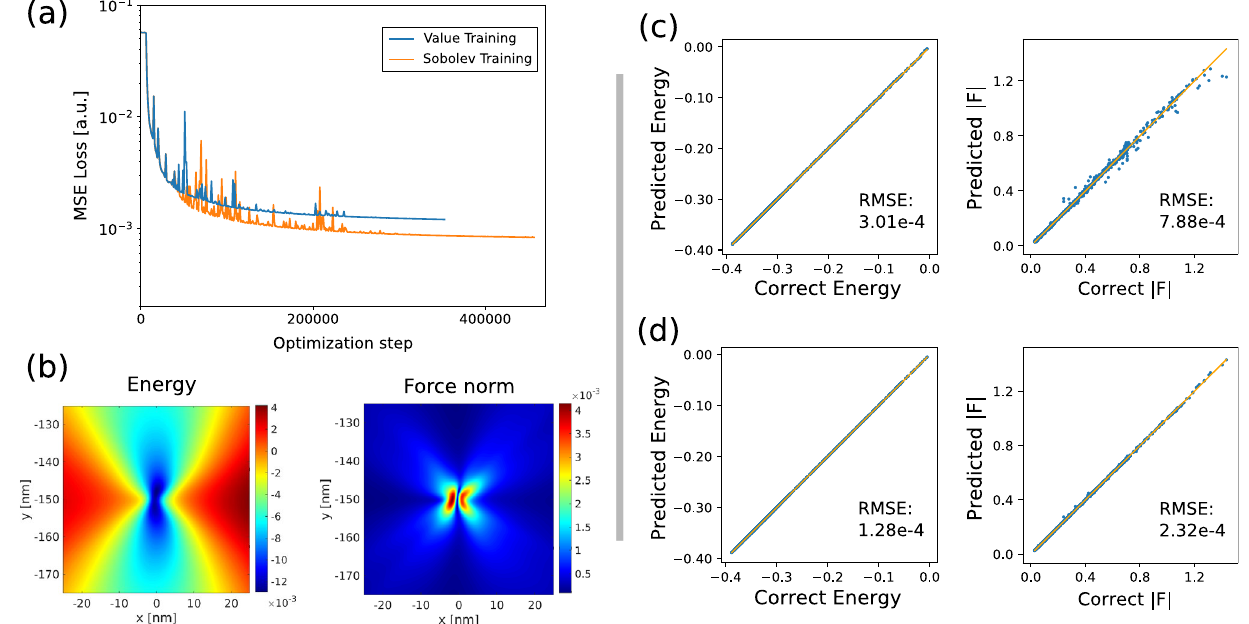
Figure 2. ( a ) Loss function calculated on the validation set during NN parameters optimization using Value (blue line) and Sobolev training (orange line). ( b ) Plot of energy and force near a dislocation as predicted from the NN model. Regression plots for the H term (both energies and forces) obtained from the model predictions on a validation set. A free surface with a perturbation of 60 nm amplitude was considered: value training ( c ) and Sobolev training ( d